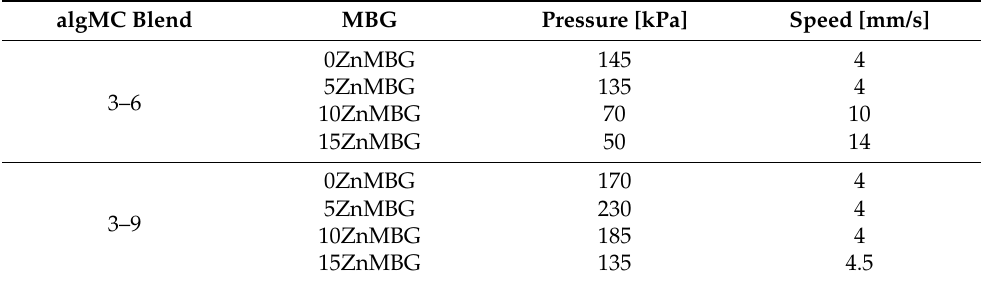
Table 2. Three-dimensional printing parameters of composite inks containing 7% of